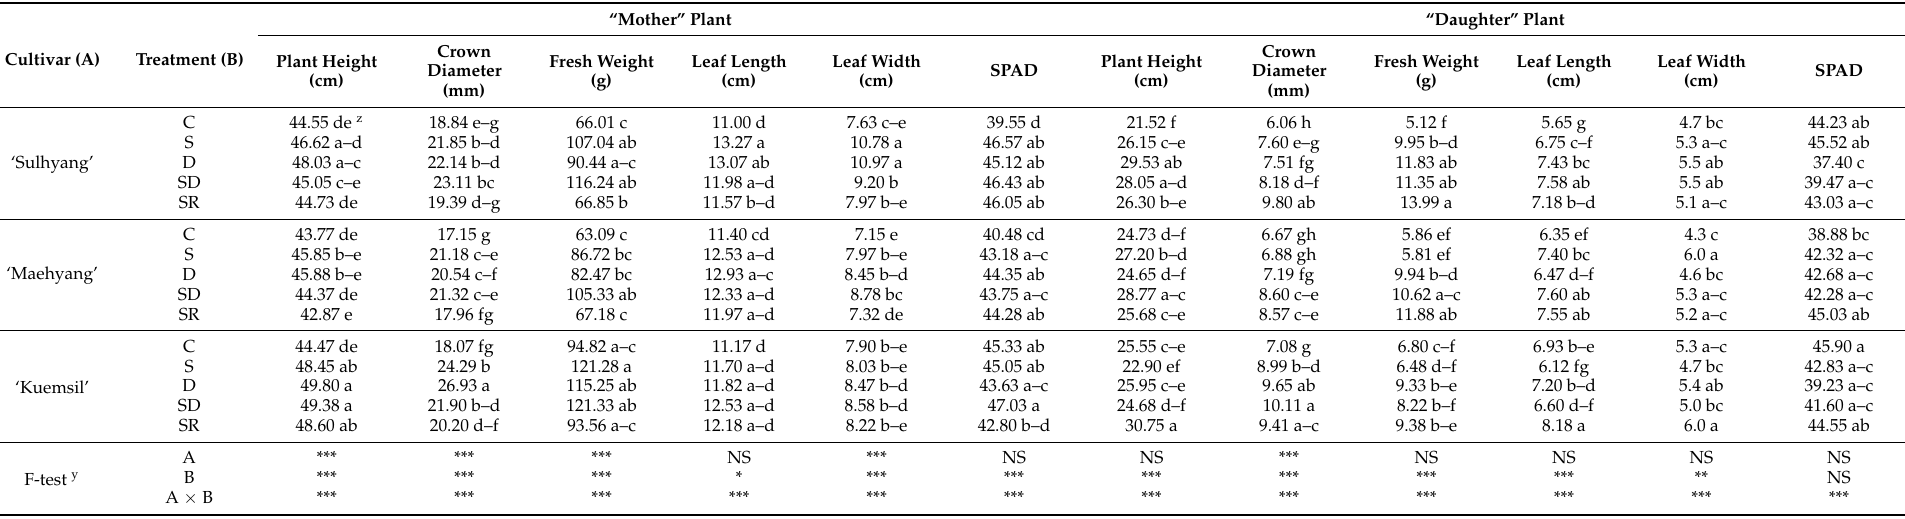
Table 1. The growth parameters of strawberry plants under different Si